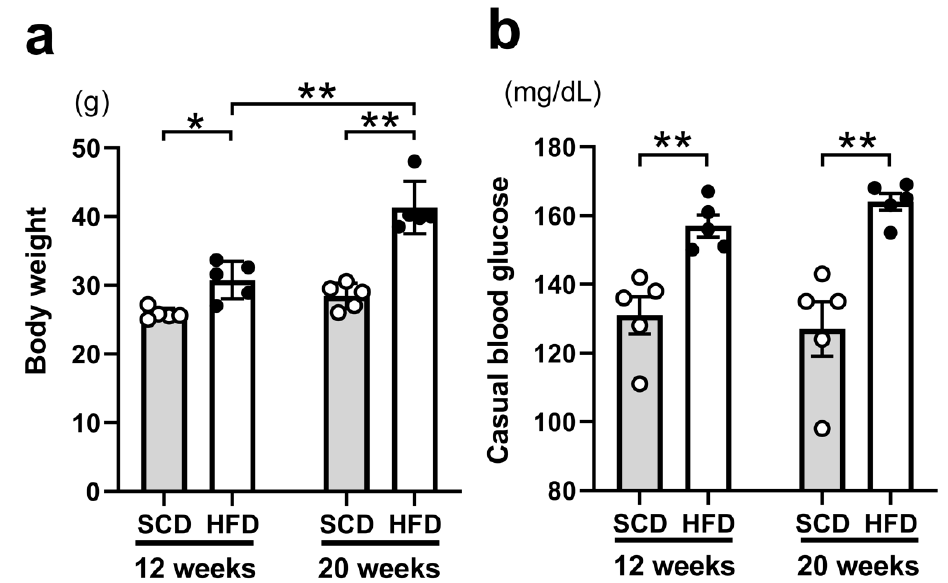
Figure 1. Comparison of the indicators of obesity and diabetes. Body weight ( a ). High-fat-diet (HFD)-fed mice showed a significantly higher body weight at 12 weeks compared to those fed a standard chow diet (SCD); the same was true at 20 weeks. Casual blood glucose levels ( b ). There were only significant differences in the diet models, with HFD resulting in significantly higher blood glucose levels at 12 and 20 weeks. The same number of animals was used in all groups (n = 5 per group). Results are presented as the mean ± SEM. * p < 0.05, ** p < 0.01 (Two-way ANOVA with Holm-Šídák’s post hoc analysis).